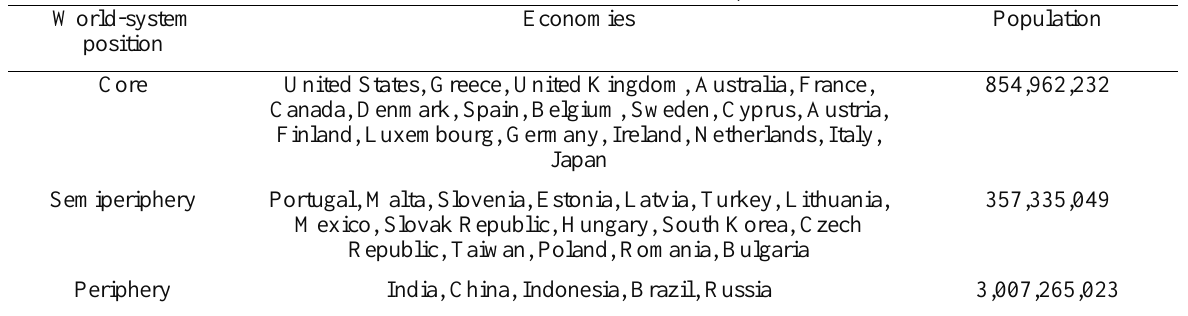
Table 4. A tentative core/semiperiphery/periphery classification of economies in the network of labor time flows,